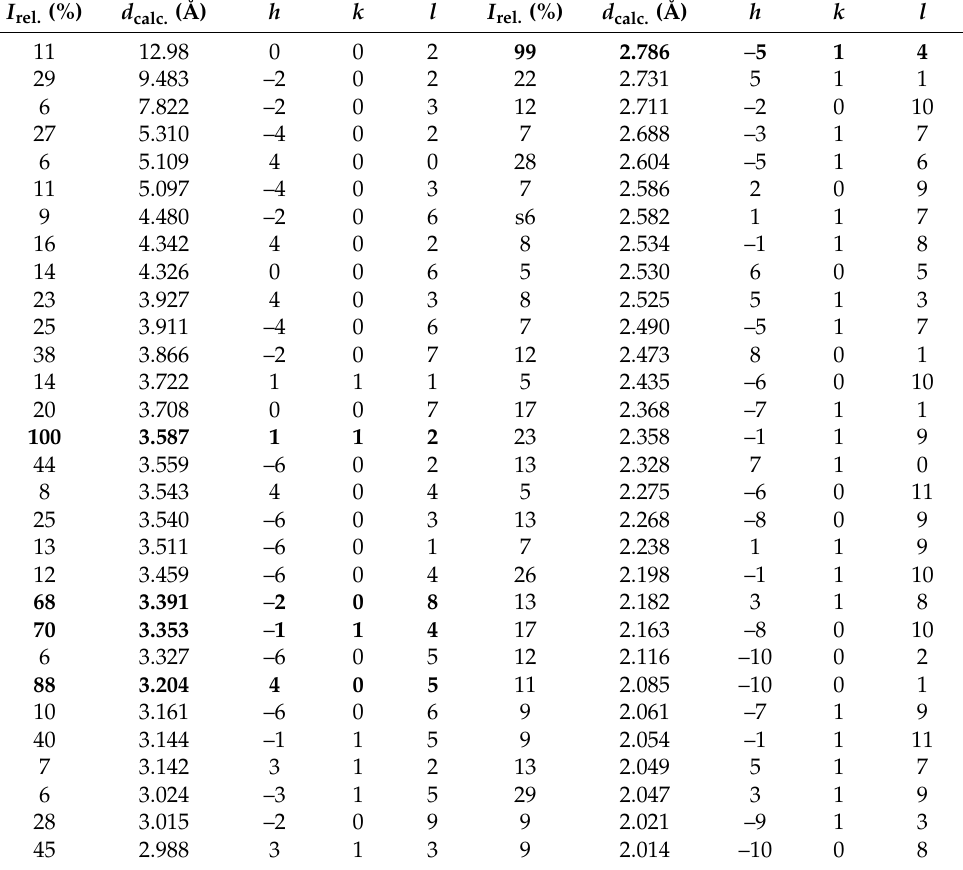
Table 3. Calculated powder X-ray data ( d values given in Å) for tsygankoite (only diffractions with I rel. > 5% are